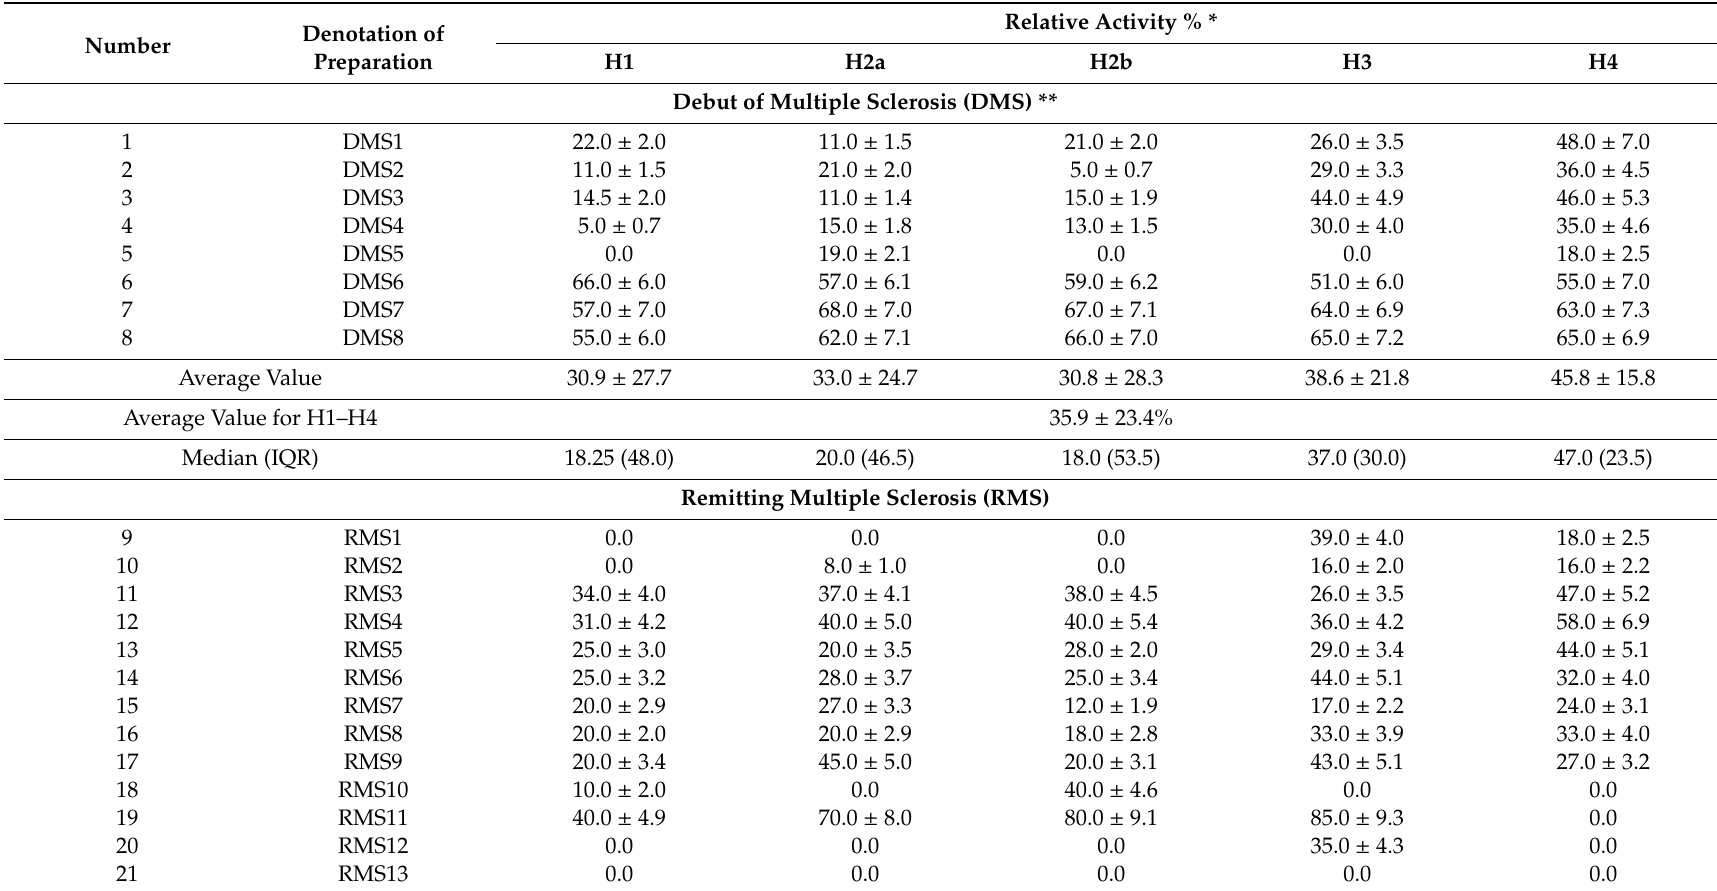
Table 1. Relative activity of polyclonal IgGs from the sera of MS patients in the hydrolysis of five di ff erent